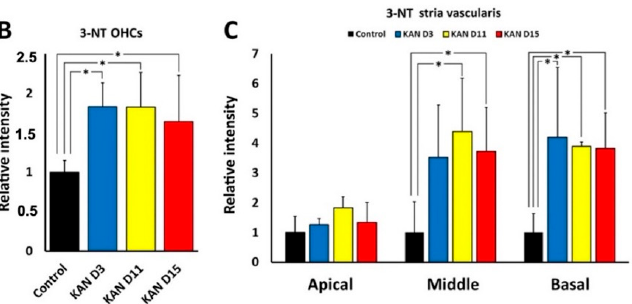
Figure 6. ( A ): 3-NT immunolabeling (magenta) at D3, D11 and D15 after kanamycin (KAN) ototoxic treatment and corresponding control. Nuclei are counterstained with DAPI (blue). In the first vertical panel, at the right of the figure, the square highlights the OHC region in the apical turn, which is enlarged in the square delimited with a broken line at the different survival times after treatment with kanamycin and in control animals. The lateral wall in the cochlear apex can also be observed. The next two panels show 3-NT immunolabeling in the lateral wall, including the stria vascularis of the middle and basal turns during treatment with kanamycin, at D3, D11 and D15 and in control animals. ( B ): Relative intensity of 3-NT immunolabeling in the OHC region of the apical turn during treatment with kanamycin, at D3, D11 and D15. ( C ): Relative intensity of 3-NT immunolabeling in the stria vascularis of the apical, middle and basal turns during treatment with kanamycin, at D3, D11 and D15. Asterisks indicate statistical significance values, as specified in Section 2.6, Materials and Methods.